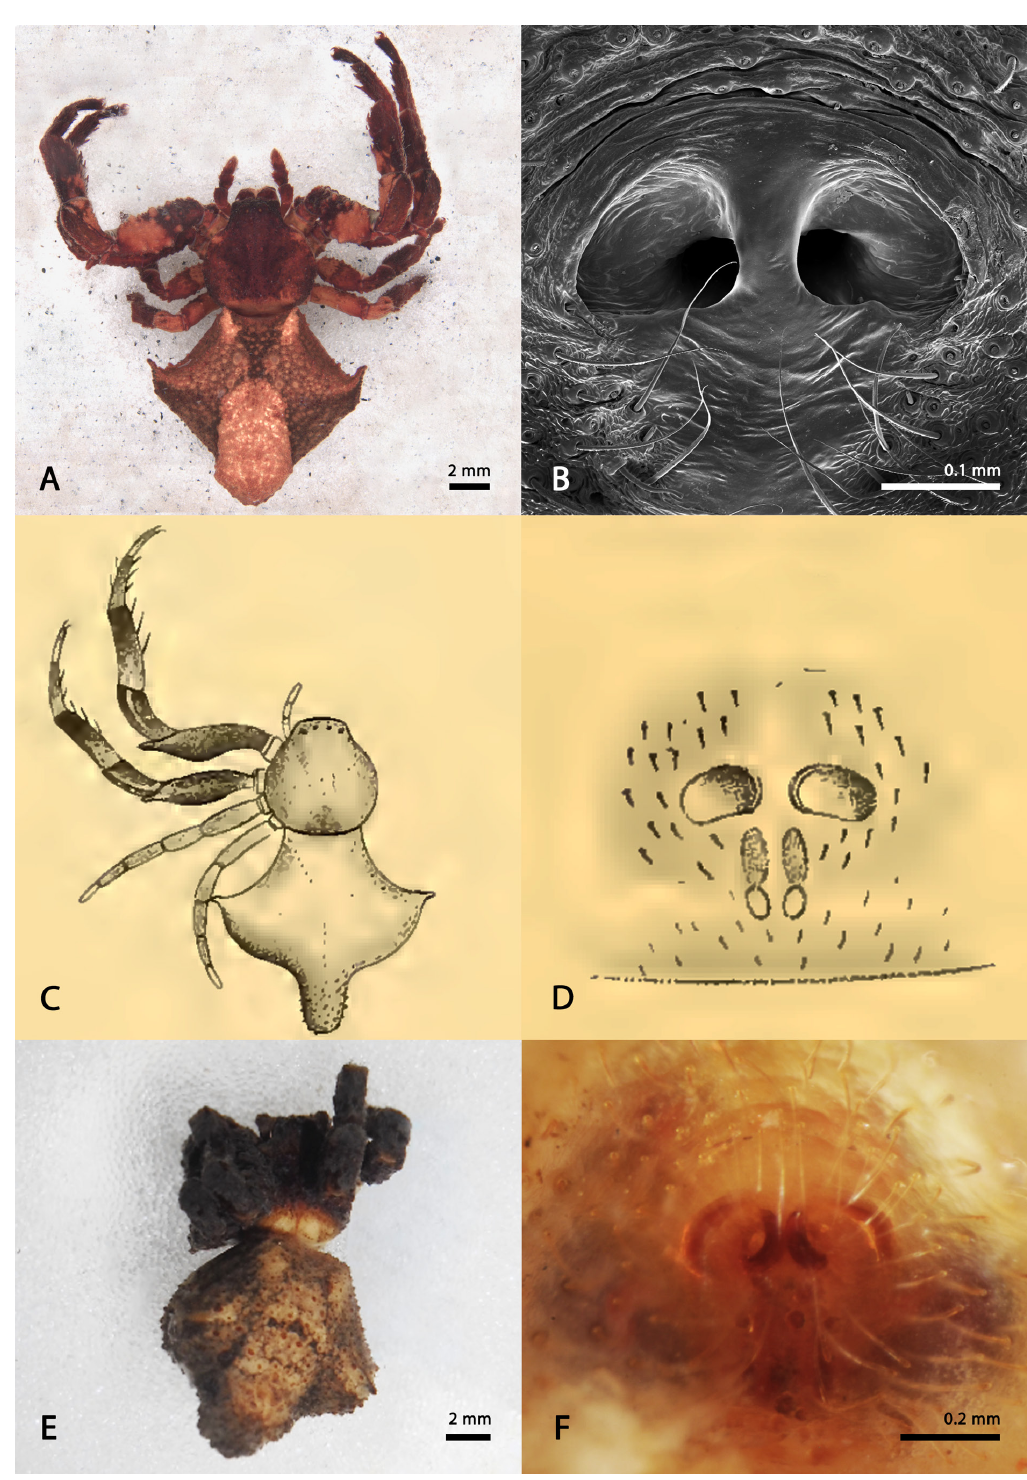
Fig. 27. A–B . Female of Epicadus caudatus (Mello-Leitão, 1929) (MCTP 7593) for comparison. A . Habitus, dorsal view. B . Epigynal plate, ventral view. — C–D . Sketches from the original description of Stephanopis stelloides (Walckenaer, 1837). C . Habitus, dorsal view. D . Epigynal plate, ventral view. — E–F . Stephanopis trilobata Mello-Leitão, 1929. Holotype, ♀ (MNHN 21629). E . Habitus, dorsal view. F . Epigynal plate, ventral